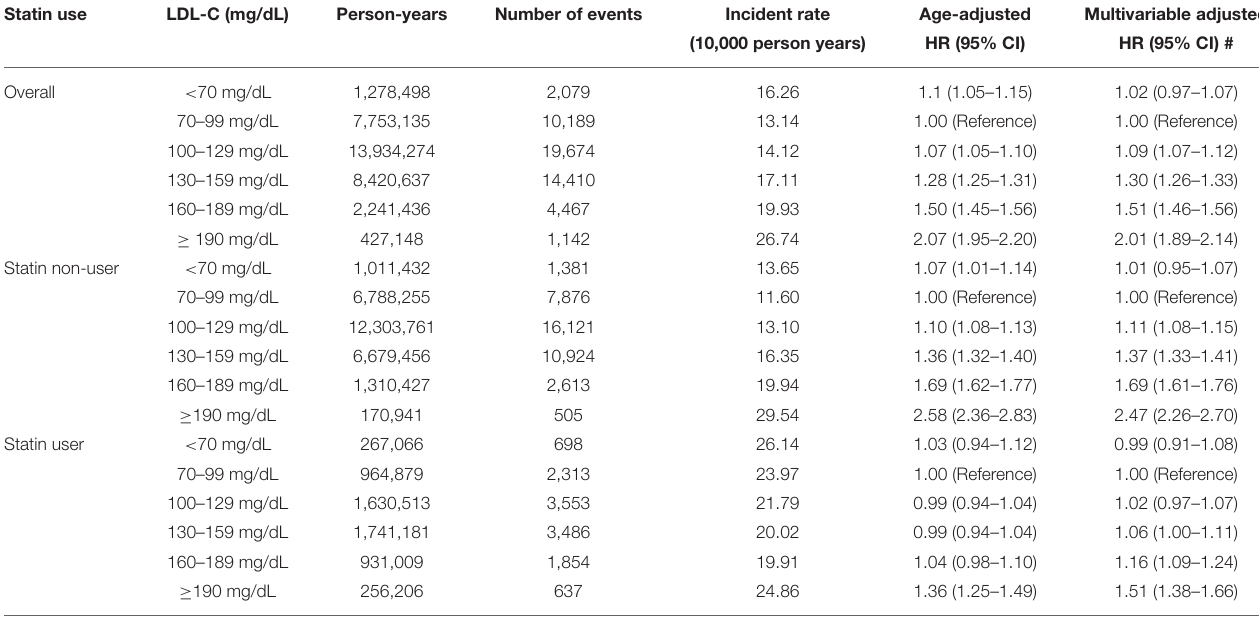
TABLE 2 | Risk of primary outcome according to the baseline LDL-C levels excluding subjects who died within 2 years of